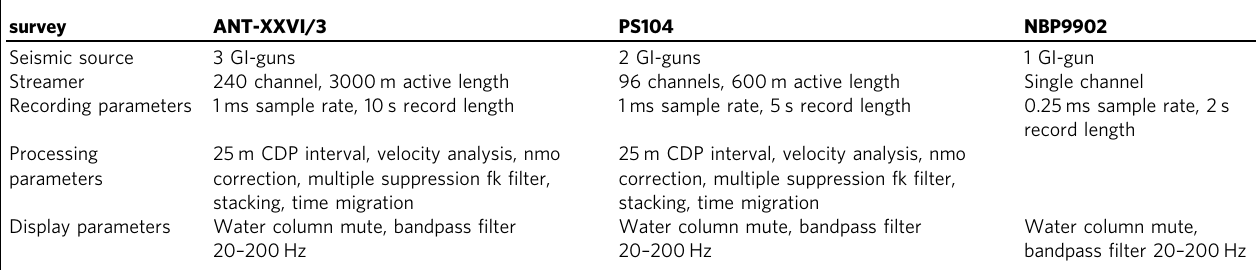
Fig. 6 Seismostratigraphic model. The model is based on the original interpretations of Gohl, et al. 35 (&) and Gohl, et al. 37 ($) but incorporates information from Sites PS104_20-2 36 (*) and PS104_21-3 38 . The age of seismic horizon ASS-u2 (#) has been inferred in this manuscript. From left to right: chronostratigraphic age, seismic units, seismic horizons, and age ranges sampled by the two seabed cores. Table 1 Acquisition and processing parameters of used seismic